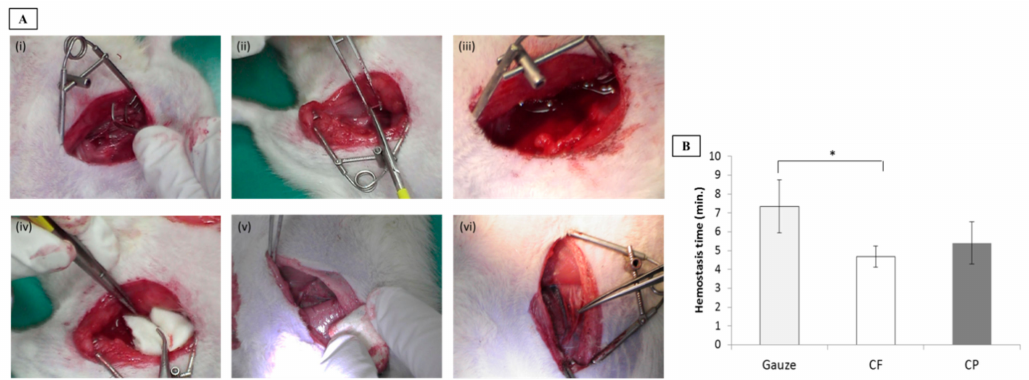
Figure 4. Hemostatic e ffi cacy of dressings tested on a rat femoral artery hemorrhage model. ( A ) Schema of rat femoral artery wound treatment. ( B ) Hemostasis time analysis (CF, chitosan fiber; CP, chitosan sponge), *p <